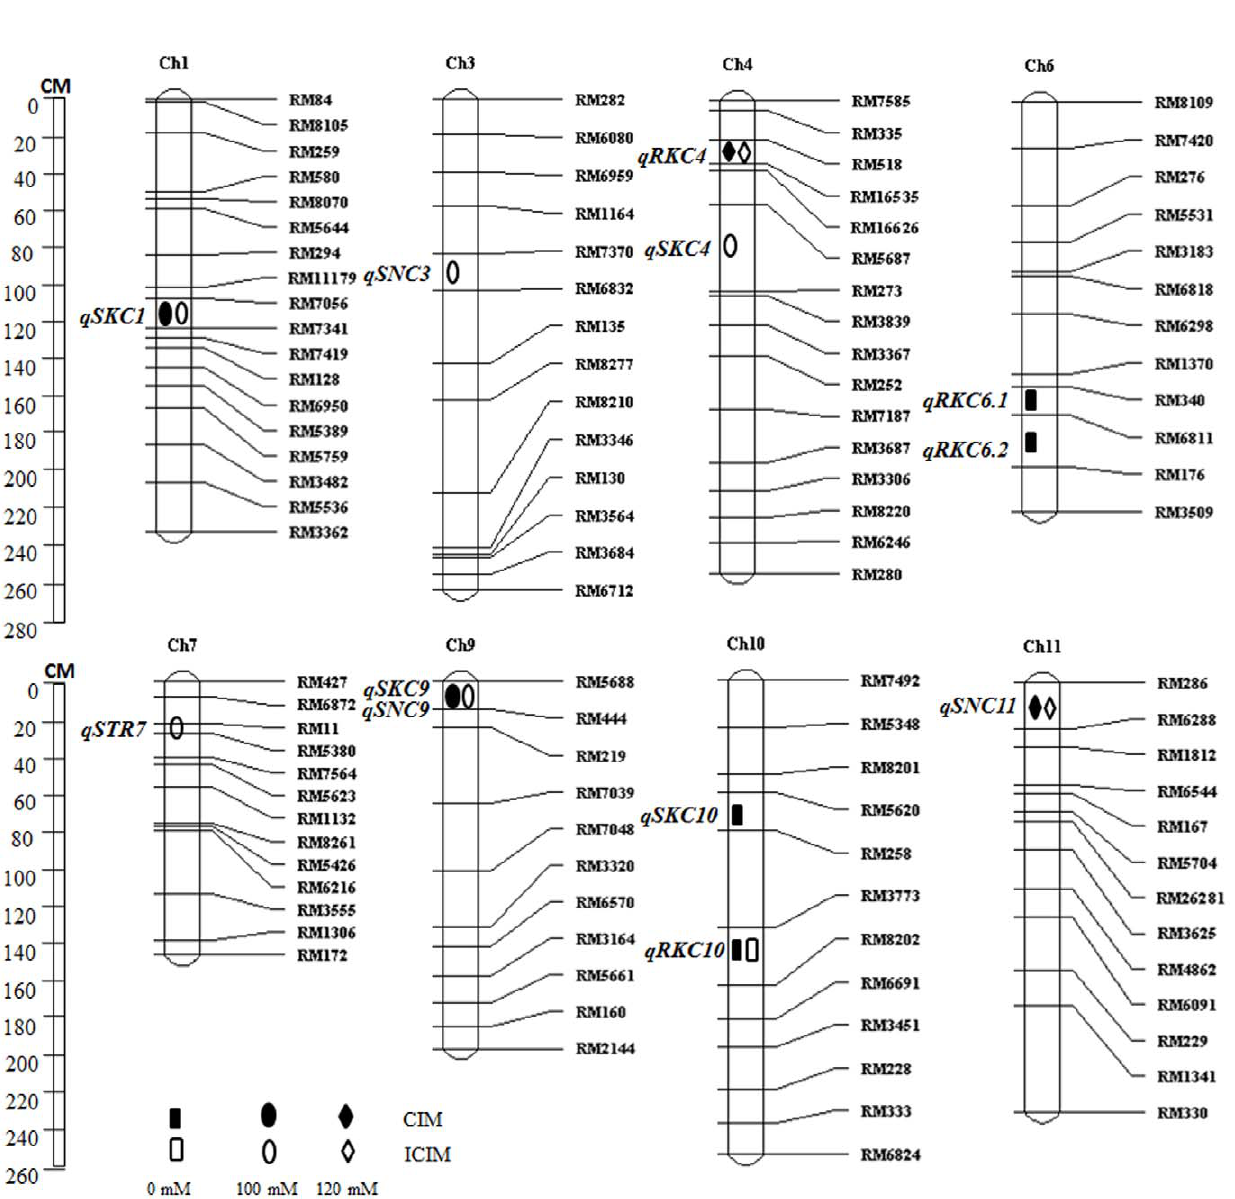
Figure 1. Location of additive QTLs for salt tolerance indices under 0, 100 and 120 mM NaCl conditions on linkage groups by CIM and ICIM. only under control and 120 mM NaCl conditions, whereas no QTLs were detected under 100 mM NaCl condition. The QTLs qRKC6.1 , qRKC6.2 and qRKC10 were mapped under control condition to chromosomes 6 and 10 in the marker intervals RM340-RM6811, RM6811-RM176 and RM3773-RM8202, with LOD scores ranging from 2.7 to 3.6, explaining 9.1 to 11.5% of phenotypic variance. Among them, QTL qRKC10 was mapped simultaneously by both CIM and ICIM approaches. One QTL for K + in roots ( qRKC4 ) under 120 mM NaCl condition was mapped simultaneously by both CIM and ICIM approaches to chromo- somes 4 in the marker interval RM518-RM16535, with LOD scores of 3.3 and 2.6, explaining 11.8 and 8.5% of phenotypic variance, respectively. The positive alleles of these QTLs were contributed by Jiucaiqing.